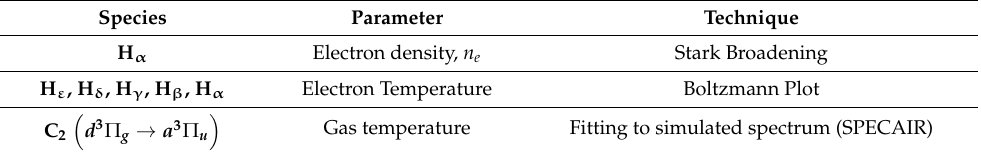
Table 3. Summary of techniques used for spectroscopic characterization of the